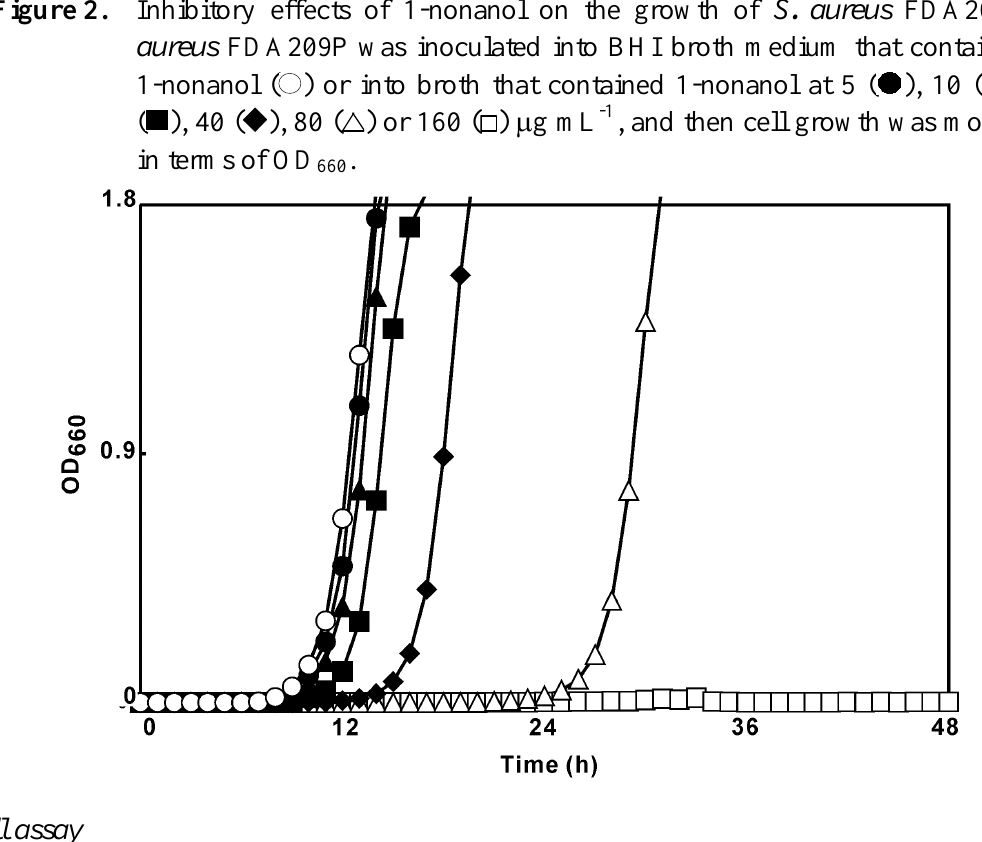
Figure 2. Inhibitory effects of 1-nonanol on the growth of S. aureus FDA209P. S. aureus FDA209P was inoculated into BHI broth medium that contained no 1-nonanol ( ) or into broth that contained 1-nonanol at 5 ( ), 10 ( ), 20 ( ), 40 ( ), 80 ( ) or 160 ( ) µ g mL -1 , and then cell growth was monitored in terms of OD . 660